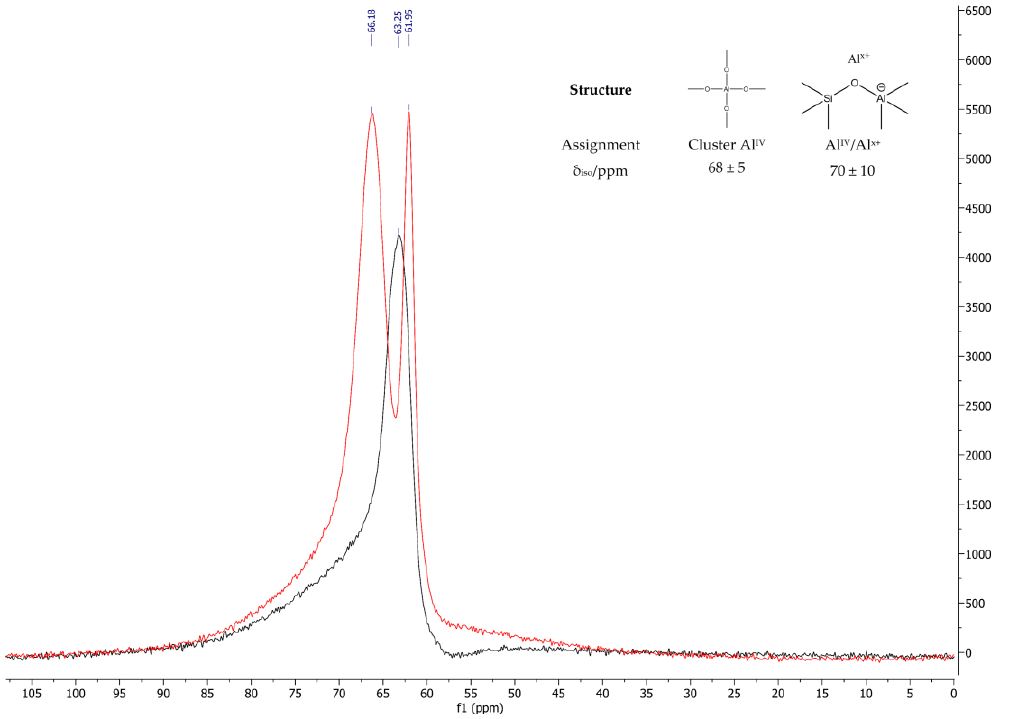
Figure 3. Solid-state NMR spectra of the modified catalyst calcined at 400 °C (black) and calcined at 1000 °C (red).